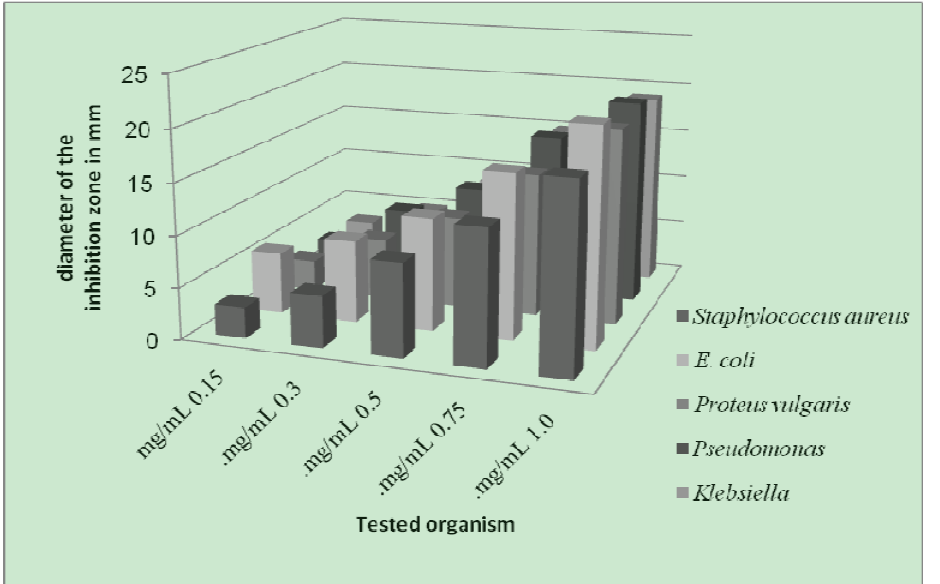
Figure 5. Effect of Ni-complex toward test